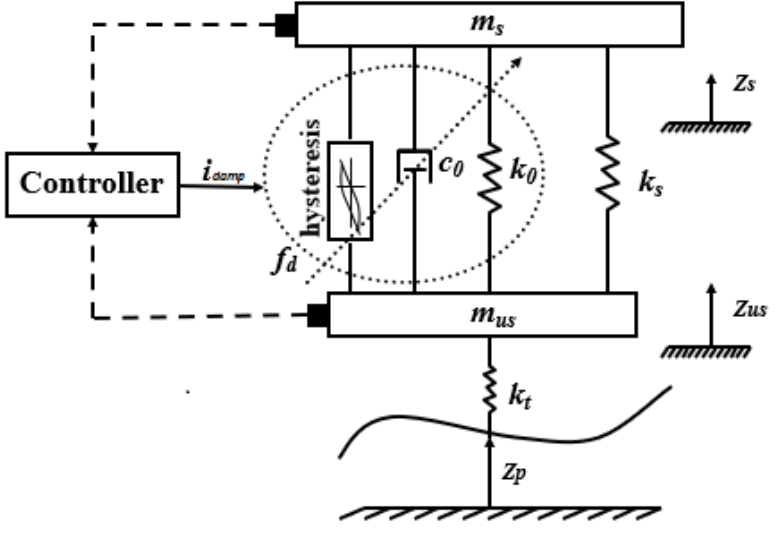
Figure 1. Semi-active One-quarter-vehicle suspension model with a magneto-rheological (MR) damper. The actuator is represented by means of the Bouc-Wen model. Figure taken and modified from